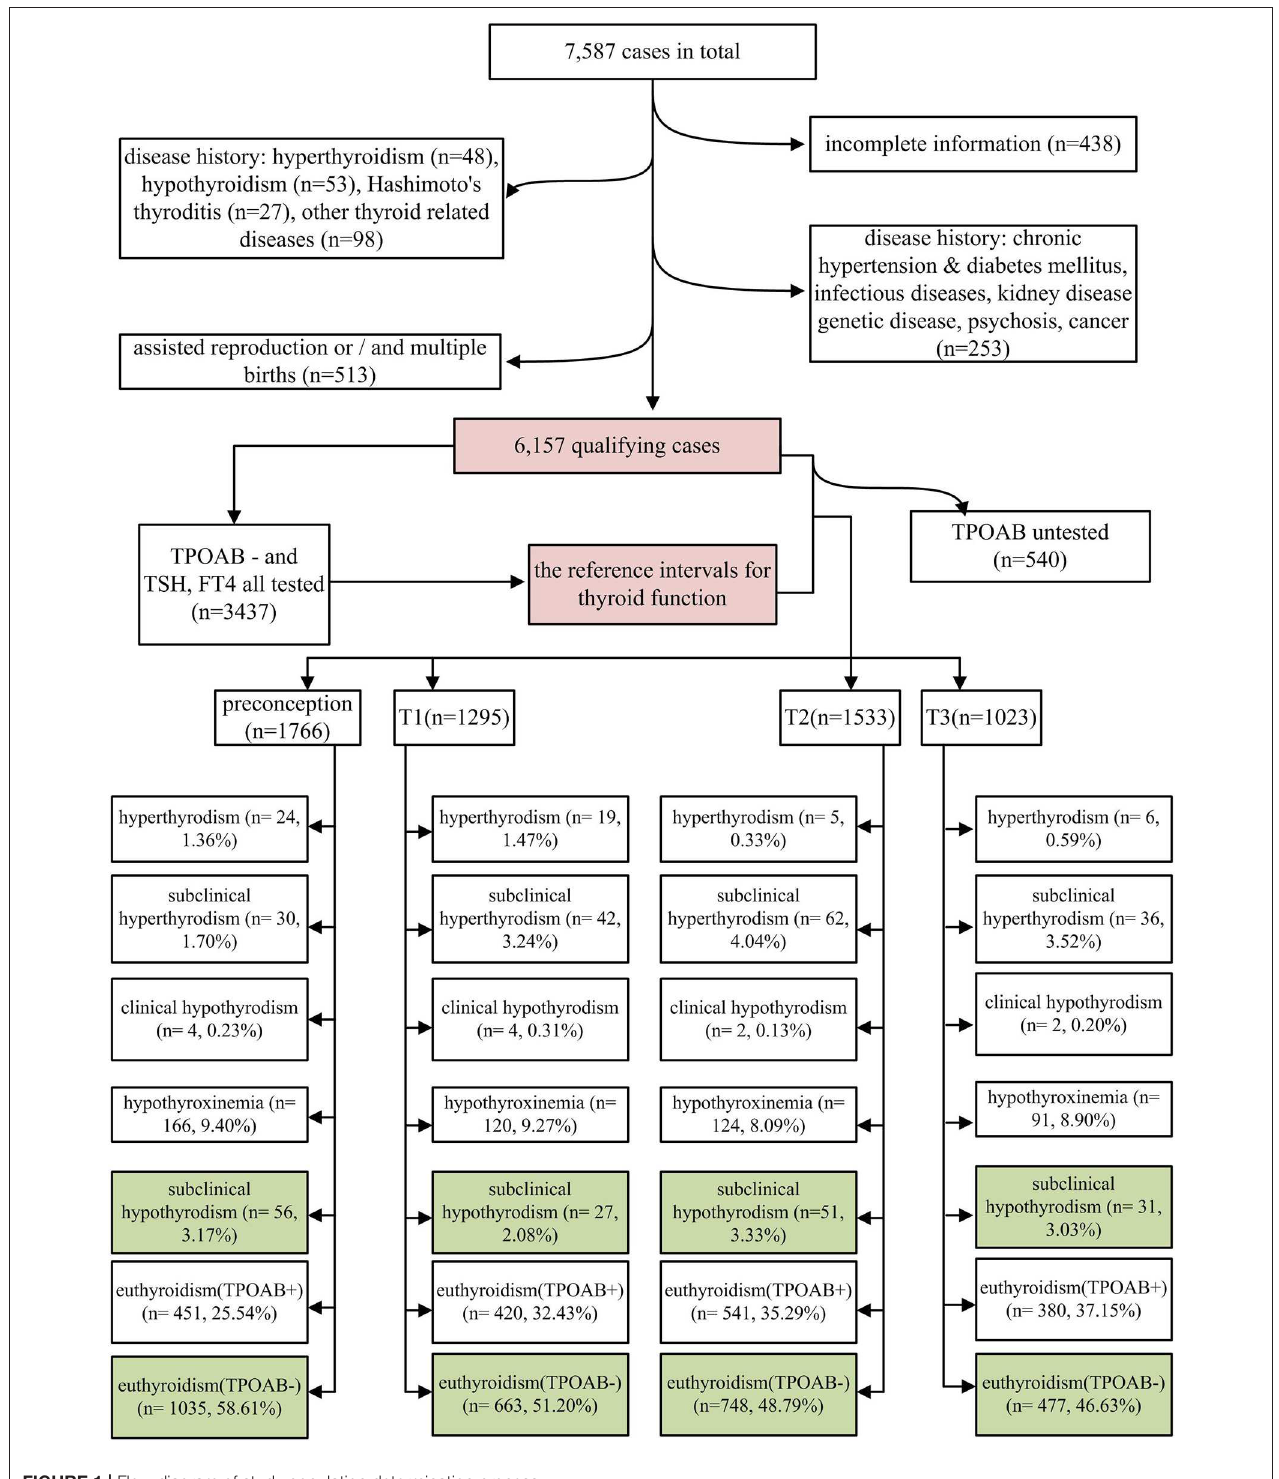
FIGURE 1 | Flow diagram of study population determination